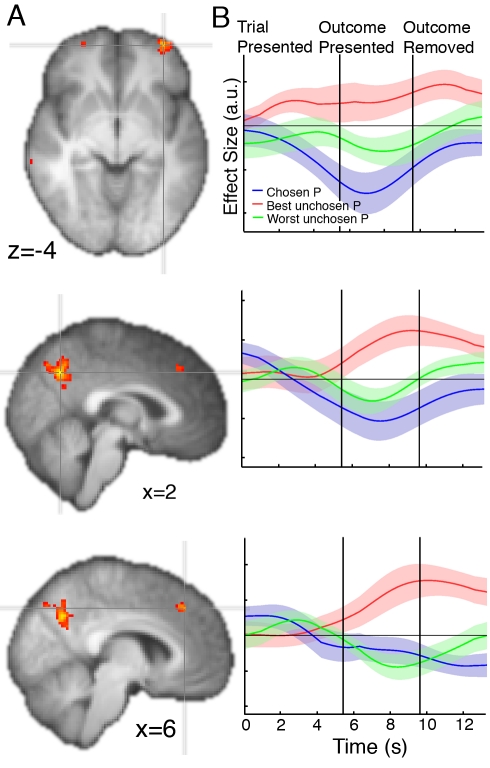
The reward-based evidence favoring future choices of the best pending option.(A) Axial and sagittal slices through z-statistic maps relating to the effect of reward probability of the unchosen option with the highest reward probability. Maps are thresholded at z>2.8, p<0.003 for display purposes, and are displayed according to radiological convention. (B) Time course of the effects of the reward probability for the chosen option (blue), the unchosen option with the highest reward probability (red), and the unchosen option with the lowest reward probability (green) are shown across the first decision-making and feedback phases. Time courses are not corrected for the hemodynamic lag. Thick lines: mean effect size. Shadows: ± s.e.m. Top row: LFPC; middle row: PMC; bottom row: DMFC.